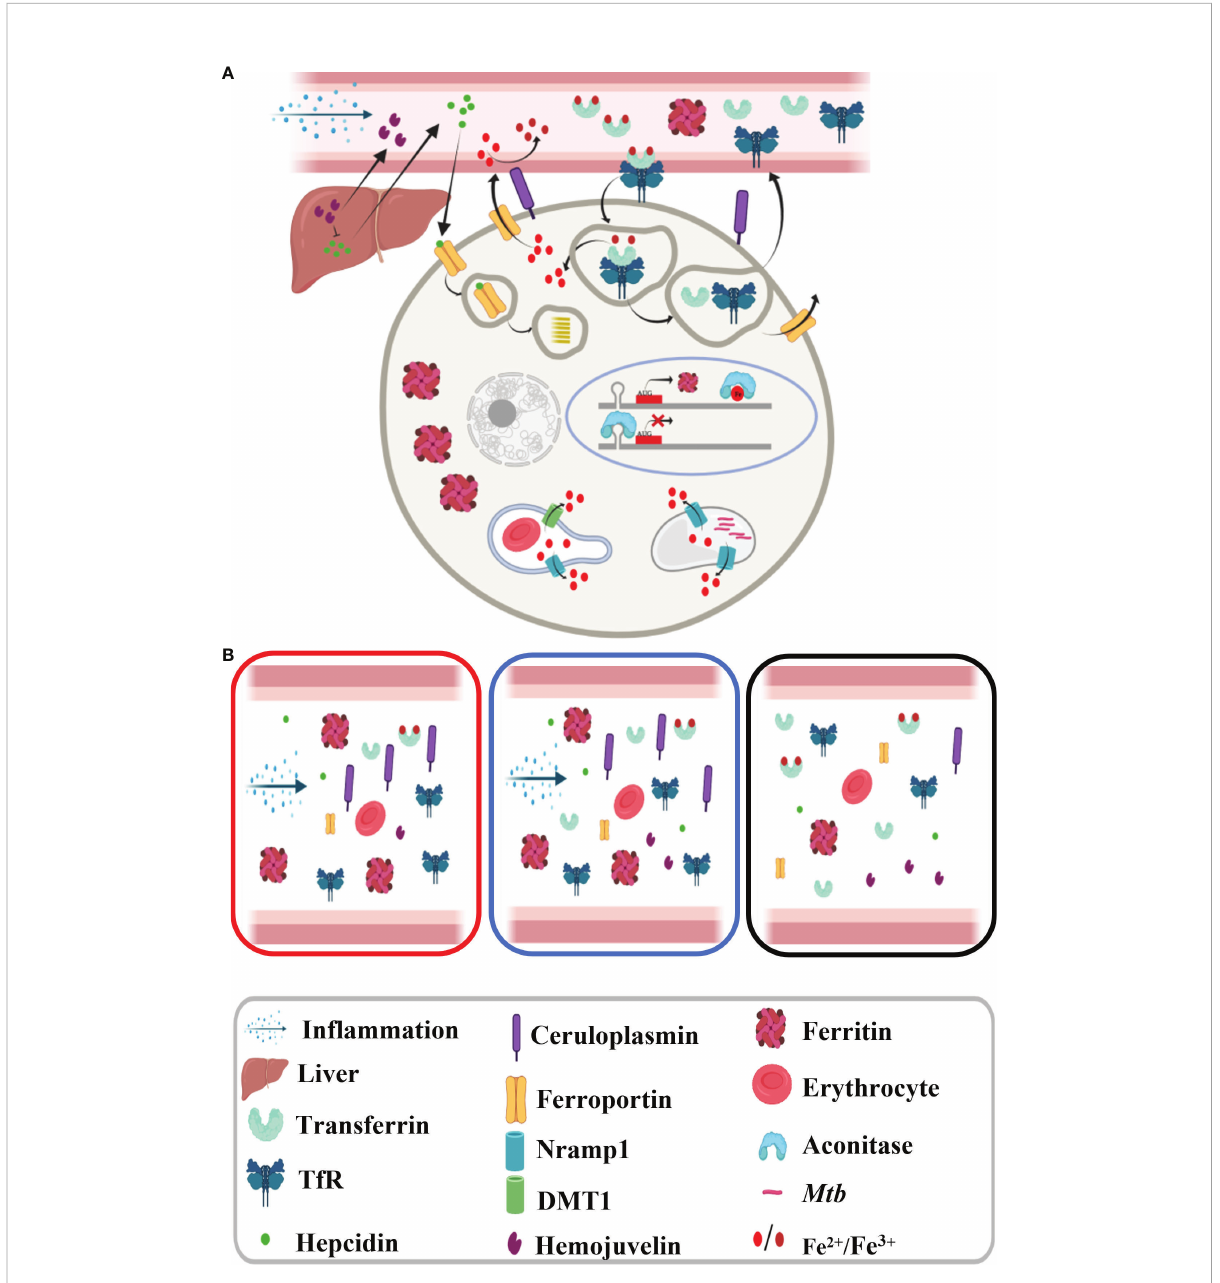
FIGURE 7 Schematic diagram showing iron metabolism in healthy subjects. (A) Macrophage showing iron metabolism homeostasis and (B) dysregulated iron metabolism in tuberculosis patients and non-tuberculosis subjects compared to healthy